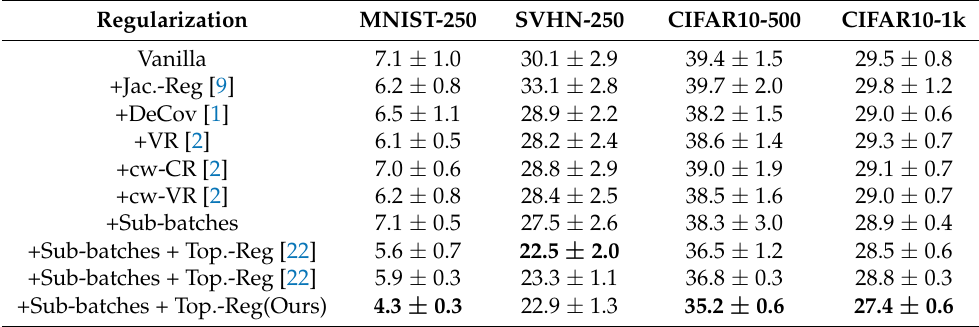
Table 1. Comparison to previous regularizers. “Vanilla” includes batch normalization, dropout and weight decay. The average test error and the standard deviation are